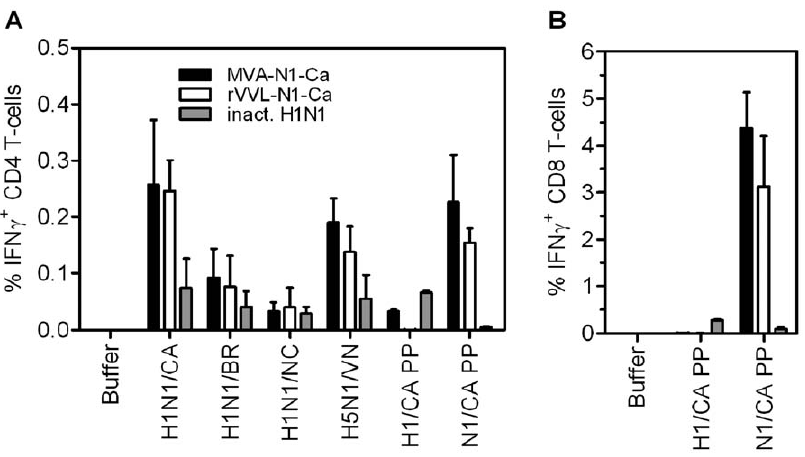
Figure 5. T cell induction by the neuraminidase expressing live vaccines. A ) Frequencies of influenza antigen specific IFN- c + CD4 T cells after immunizing two times with MVA-N1-Ca (black bars), rVVL-N1-Ca (white bars) or inactivated vaccine (grey bars) and stimulation with buffer and with different antigens and peptides (shown on x-axis). Splenocytes were stimulated with protein antigens as described in the legend of Fig. 4. B ) Frequencies of influenza neuraminidase-specific IFN- c + CD8 T-cells after two dosages of vaccine. Splenocytes were stimulated with the peptide pools indicated in the legend of Fig. 4. The data are mean values ( + / 2 SEM) of two independent experiments.